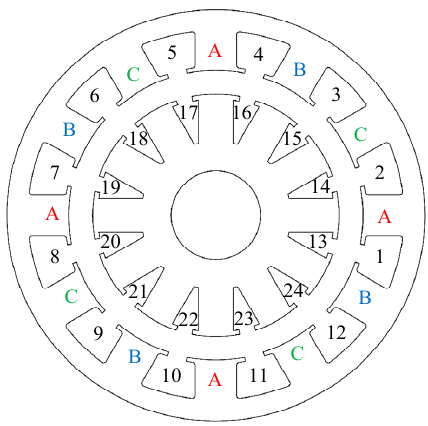
Figure 23. Distribution of phases and slot numbers of 12/8 DSSRM.